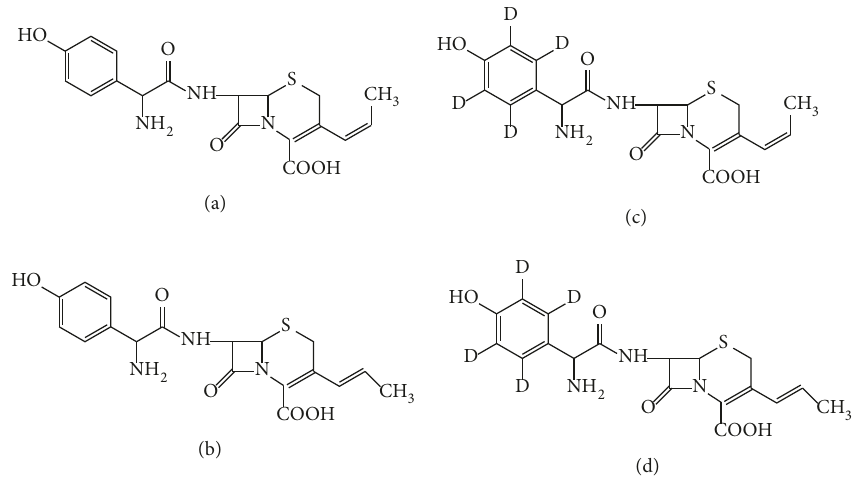
Figure 1: Chemical structures of cis -cefprozil (a), trans -cefprozil (b), cis -cefprozil-D4 (c), and trans -cefprozil-D4